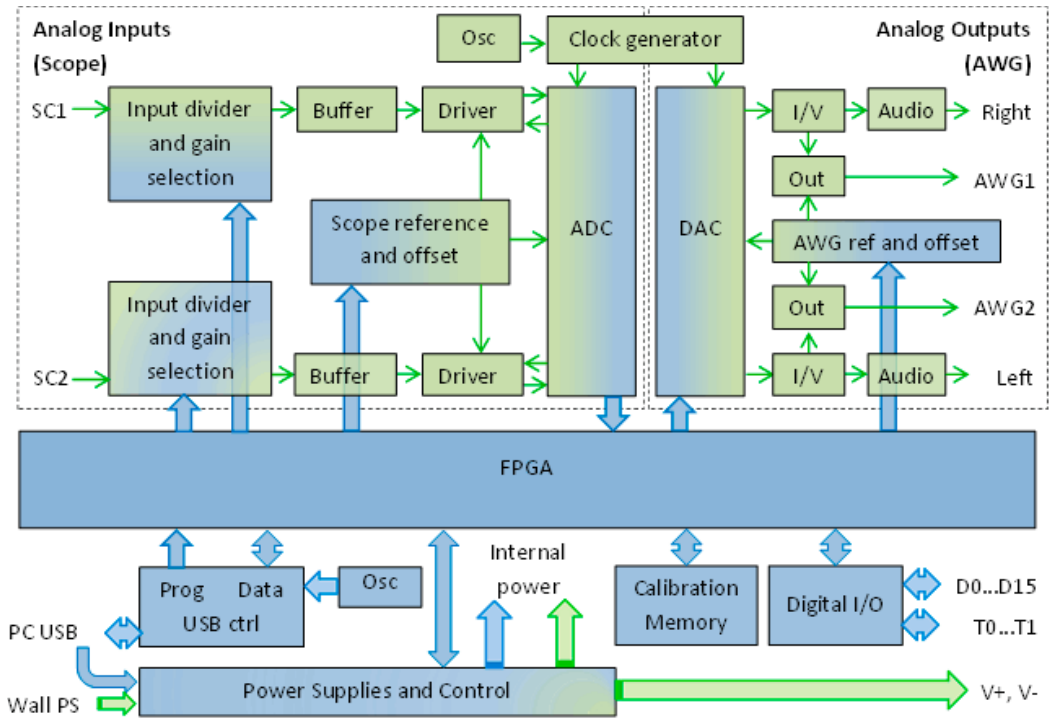
Figure 7. Structure of the Analog Discovery 2 (AD2) module adapted from its datasheet.